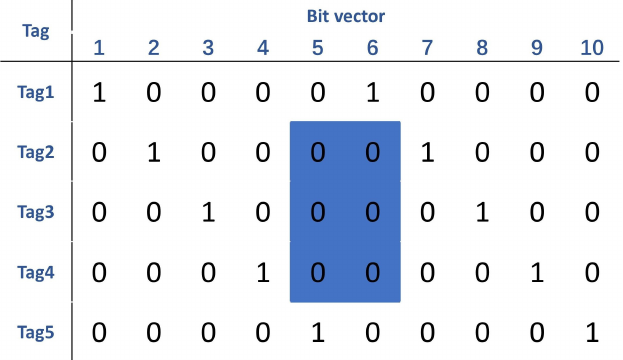
Figure 4. Bit vectors and the selection of node2, node3, and